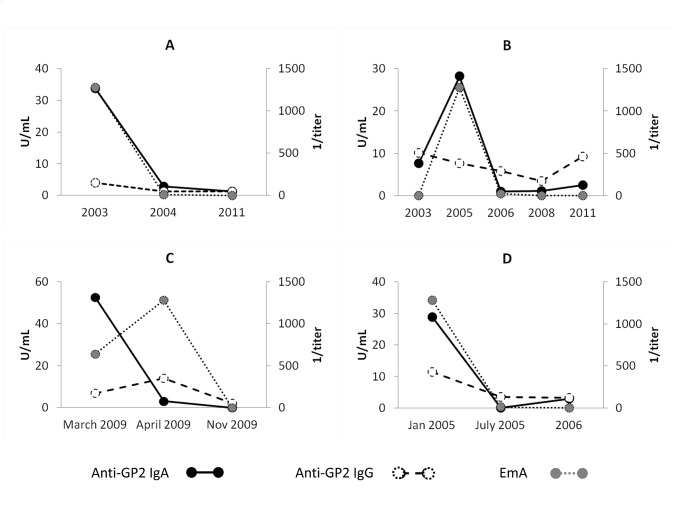
Antibody kinetics in 4 celiac disease patients.Antibody kinetics in 4 celiac disease patients (A-D) with at least two consecutive samples before and after the onset of a gluten free diet. In fact, in all patients anti- glycoprotein 2 (GP2) IgA levels were reduced to values below the cut-off. Interestingly, in one patient (patient B) with co-existing type 1 diabetes who became positive for anti-GP2 IgA in parallel with anti- tissue transglutaminase (tTG) IgA, anti-GP2 IgA turned also negative under gluten free diet.